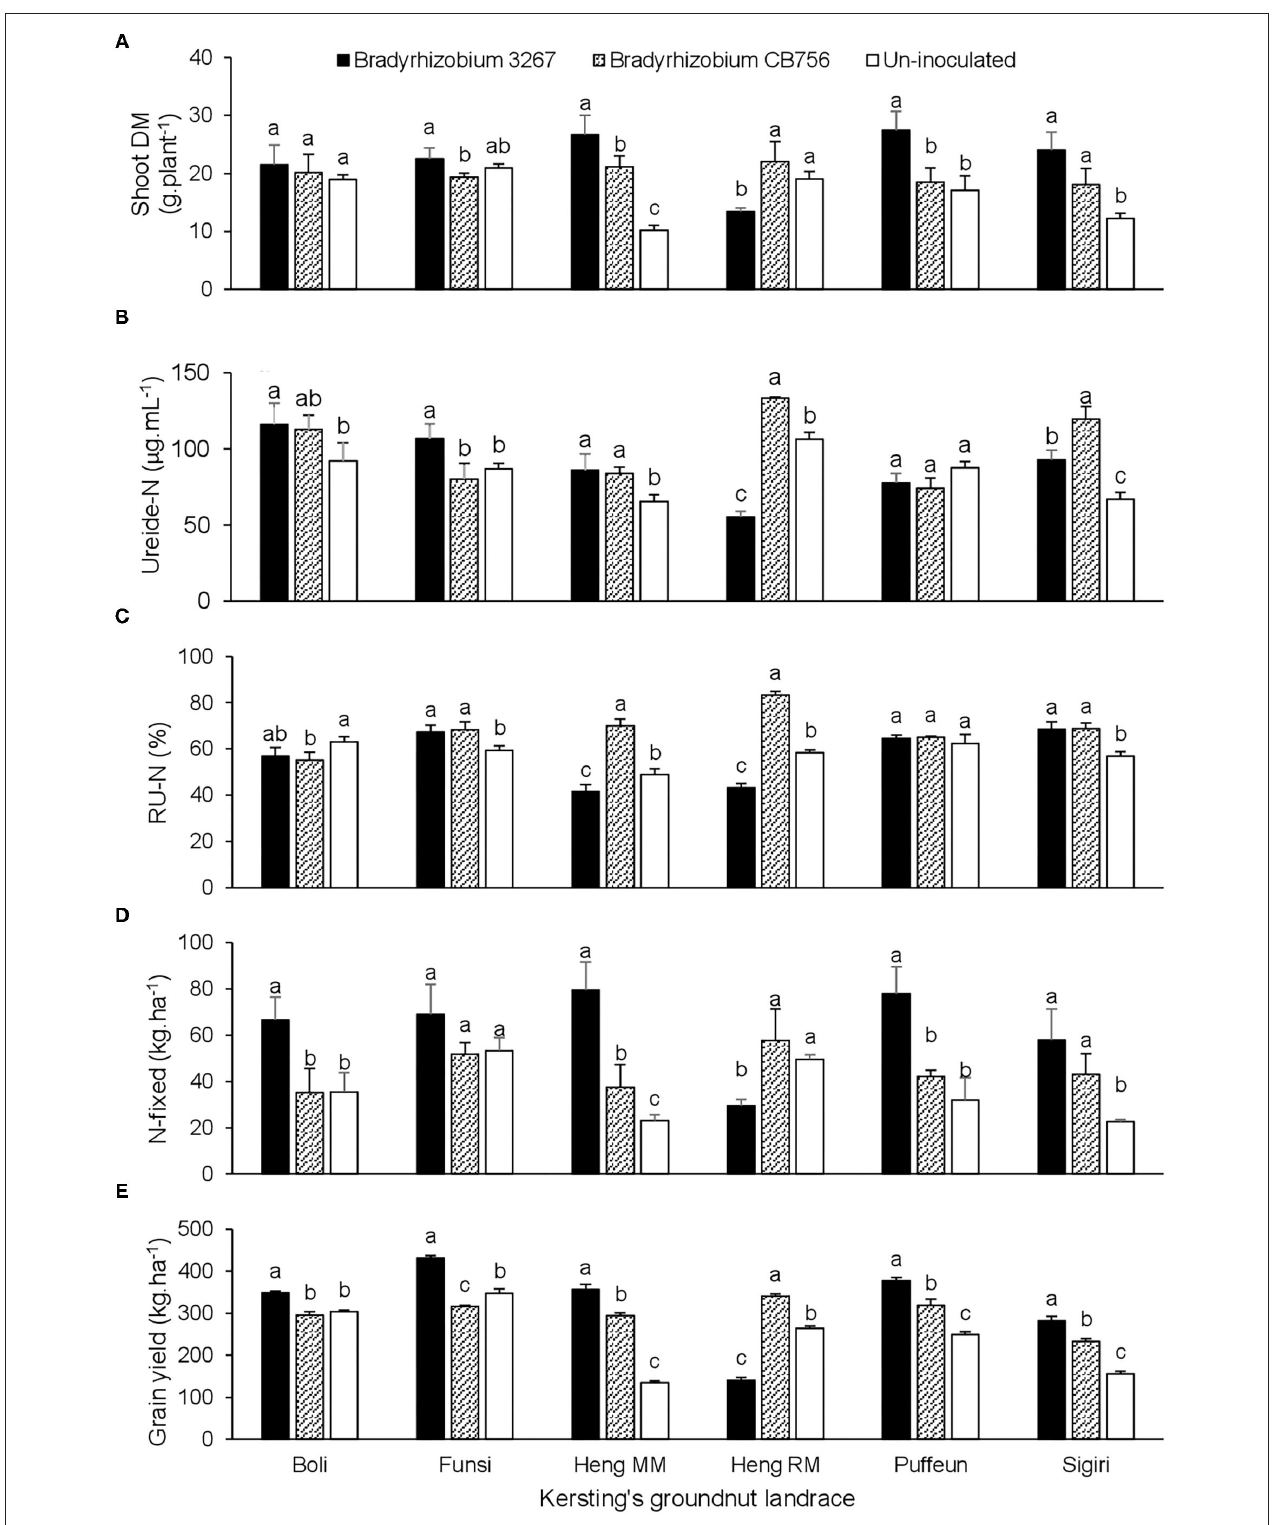
FIGURE 3 | The interactive effect of landrace × inoculation on (A) shoot dry matter, (B) ureide-N in xylem sap, (C) relative ureide-N (RU-N), (D) N-fixed, and (E) grain yield of six Kersting’s groundnut landraces planted at Gbalahi in 2013. For each landrace, bars with dissimilar letters are significantly different ( p ≤ 0.05).